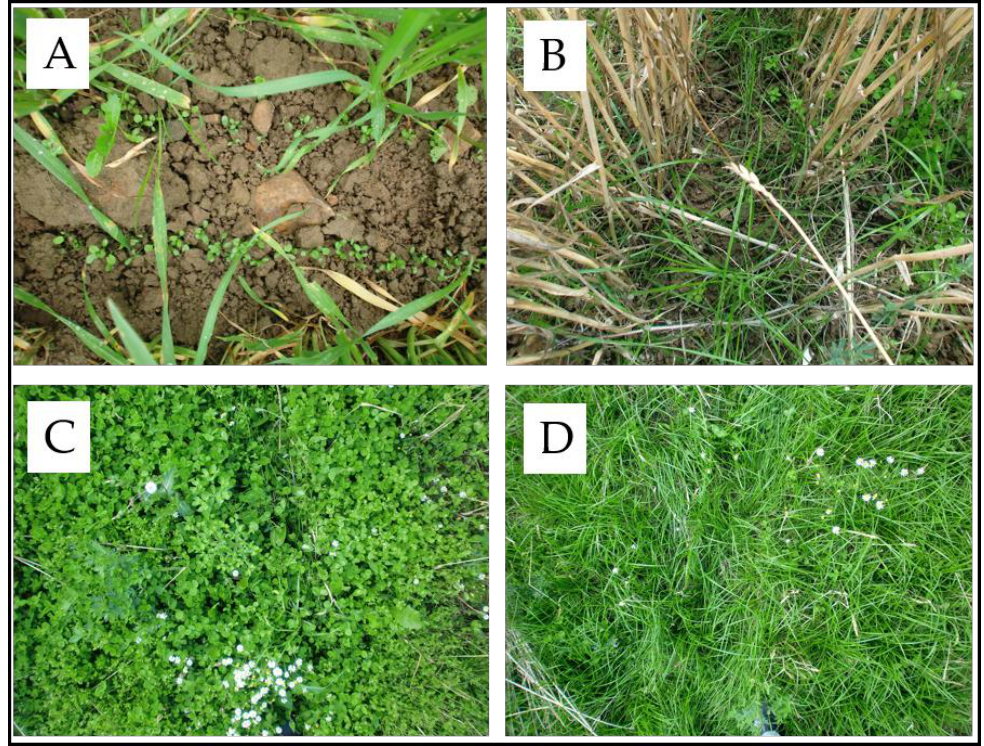
Figure 1. White clover ( A , C ) and perennial ryegrass ( B , D ) in spelt wheat and 21 days after spelt wheat harvest in the experiment No. 2 in 2010.